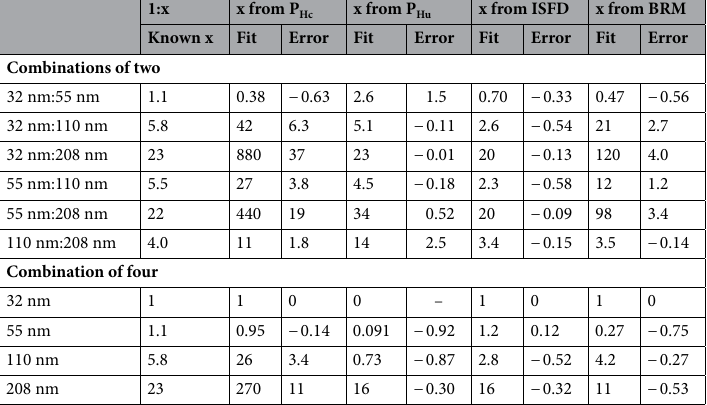
Table 1. Comparison of extracted volume ratios. The ratio x is normalized to the first type listed, i.e., in the first row x = α 55 nm / α 32 nm .